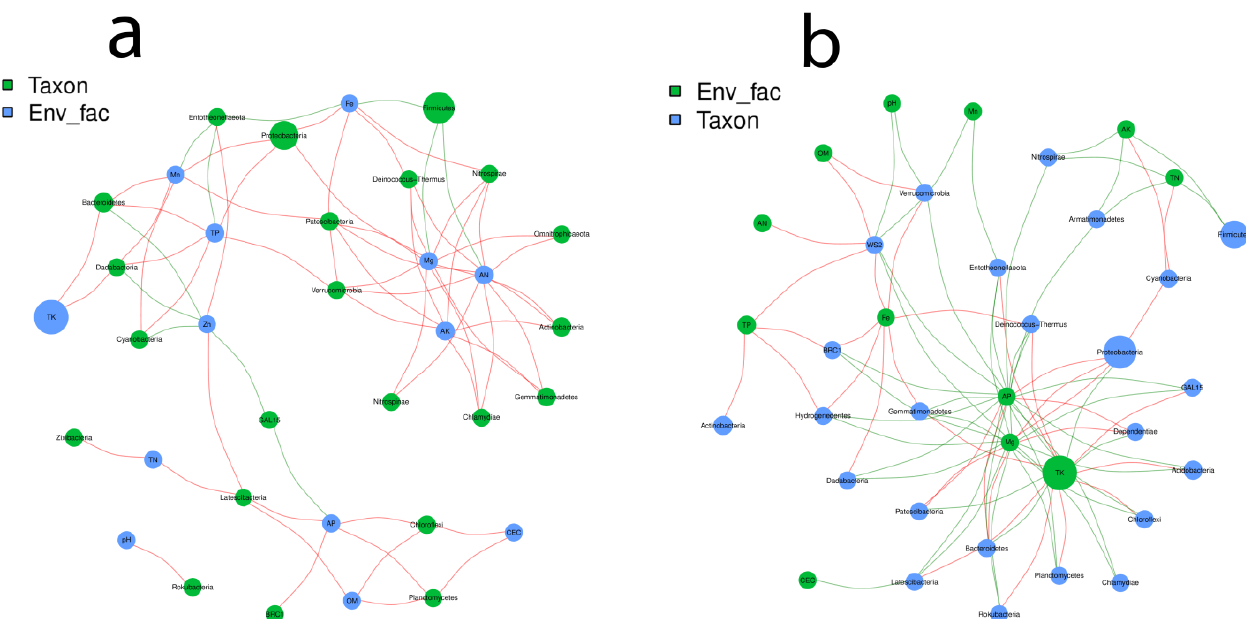
Figure 5. Pearson correlation between the edaphic soil factors and bacterial population in the soil. ( a ) Control plants, ( b ) treated plants.